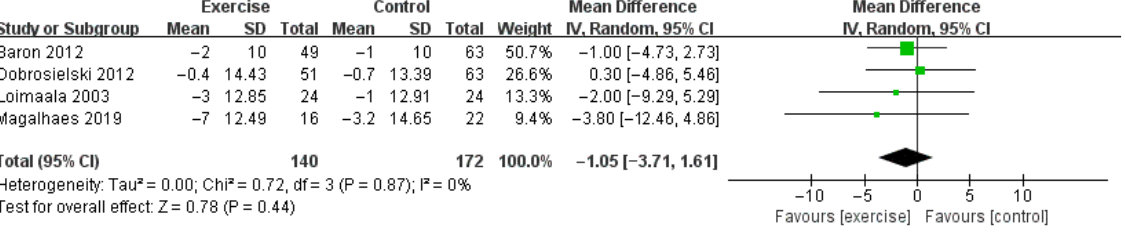
Figure 4. The result of TSA for PWV. TSA showed that the pooled results did not (z-curve, blue curve) crossed the conventional boundary of benefit (brown line) or the trial sequential monitoring boundary for benefit (upper red line), and did not reach the required sample size based on TSA ( n = 3681) [35,37,38].